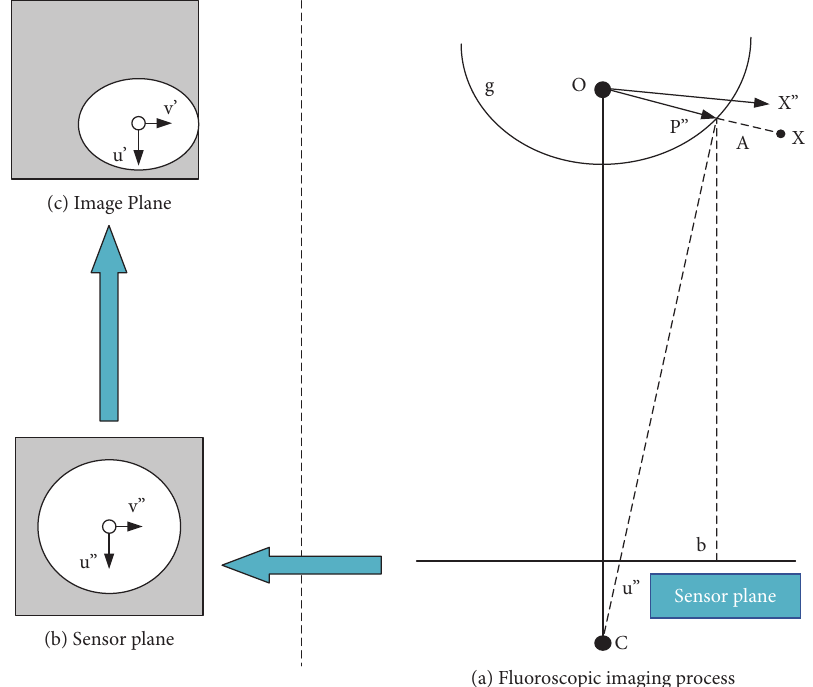
Figure 4: Single view imaging